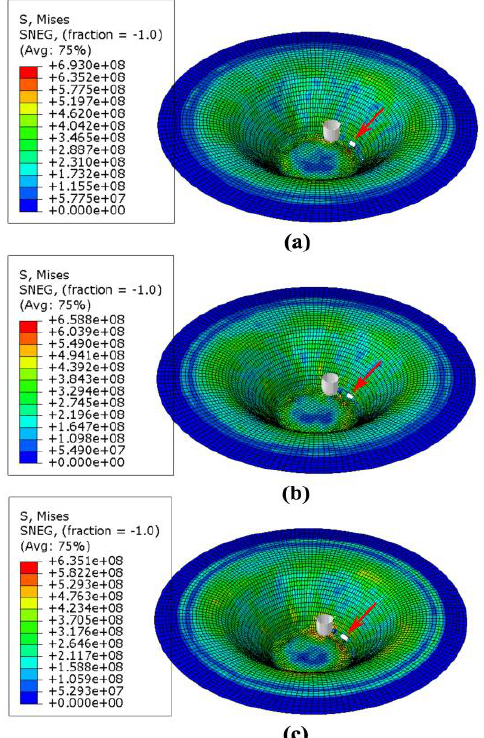
Figure 13. von Mises stress distribution for GTN material model at ( a ) no fluid pressure, ( b ) pressure 0.2 bar, and ( c ) pressure 0.4 bar. Predicted fracture regions are marked with red arrow.